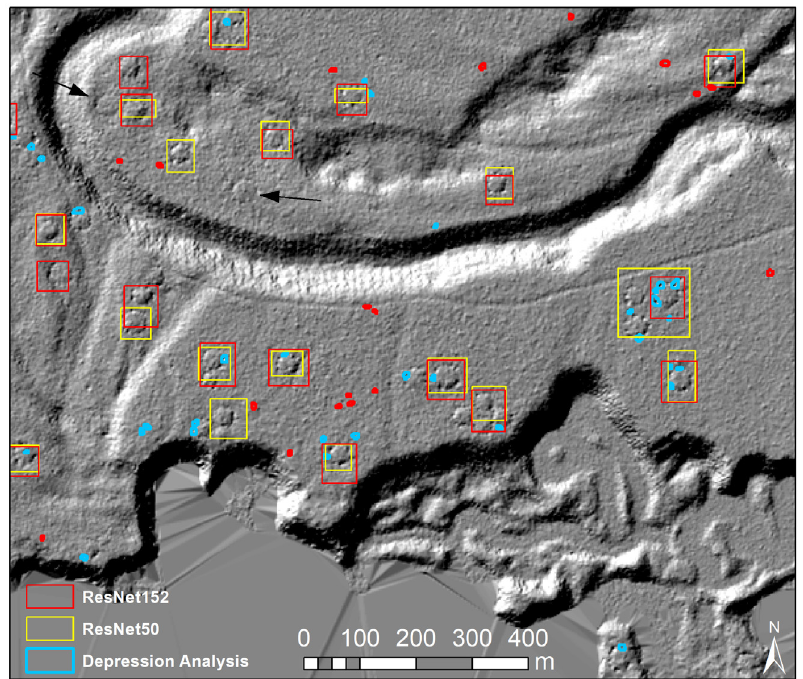
Figure 7. Comparison of detections of charcoal piles by the depression analysis and the two best performing RetinaNet models trained on ResNet50 and ResNet152. Black arrows show locations of charcoal pit features that were missed by all of the automation methods. Hillshade basemap created from Laserdata NH GSD- © Lantmäteriet (2012).